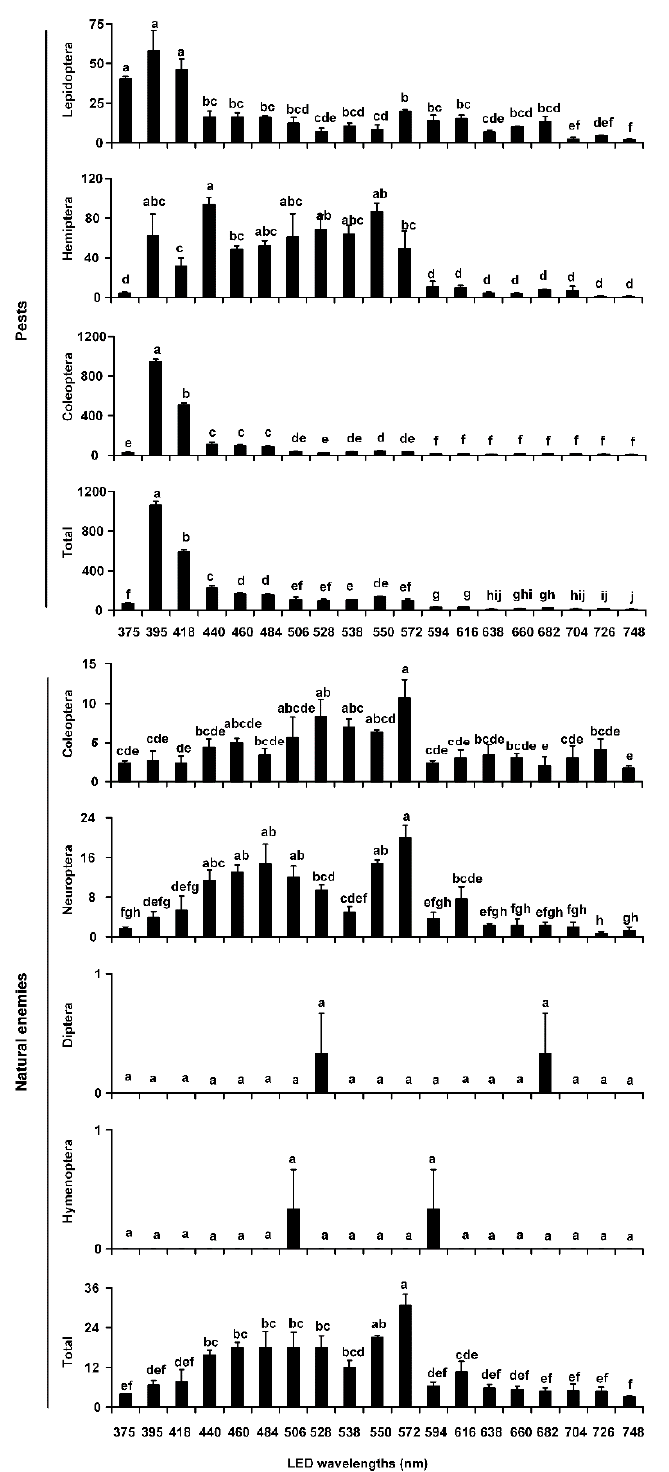
Figure 3. Average abundances of pests and natural enemies in different taxonomic groups trapped by LED-equipped traps with 19 single wavelengths in 2015. Bar charts show the average number of pests or natural enemies caught per trap, as recorded during trials in cotton fields in Xinxiang County (Xinxiang, China). Individual bars represent the mean (±SE) trap capture, with accompanying letters denoting statistically significant differences among the LED wavelengths in a given order or total pests or natural enemies (ANOVA, p < 0.05).